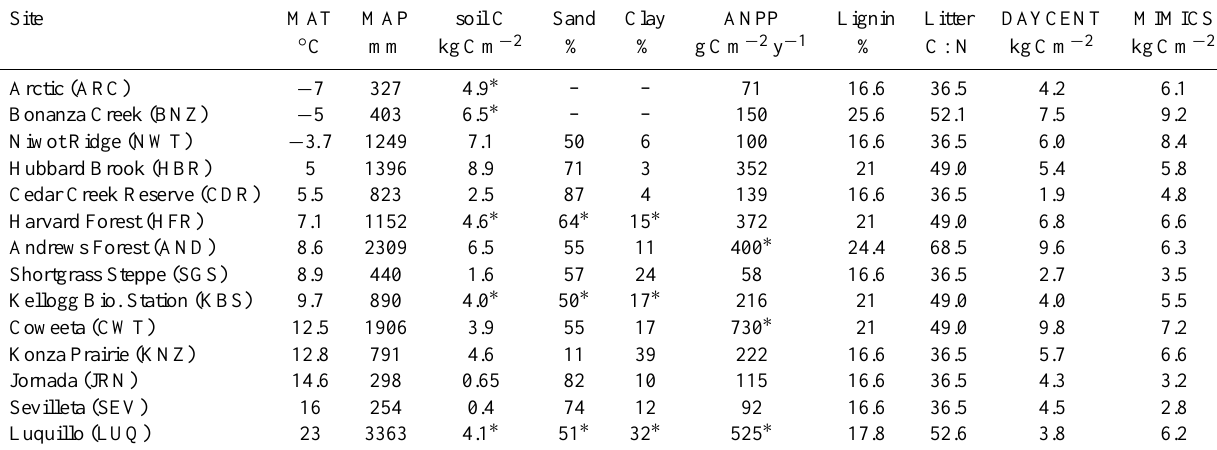
Table C1. Mean annual temperature and precipitation (MAT and MAP, respectively) (Harmon, 2013); edaphic properties (0–10cm) (Zak et al., 1994); aboveground net primary productivity (ANPP) (Knapp and Smith, 2001); litter chemistry (Brovkin et al., 2012); and steady- state SOM pools simulated by DAYCENT and MIMICS (0–30cm). Data from other sources are marked with asterisks and noted below. Where no soil texture data were available (ARC and BNZ) we used 50% sand and 5% clay for DAYCENT and MIMICS simulations. Litter characteristics for KBS follow those for grassland